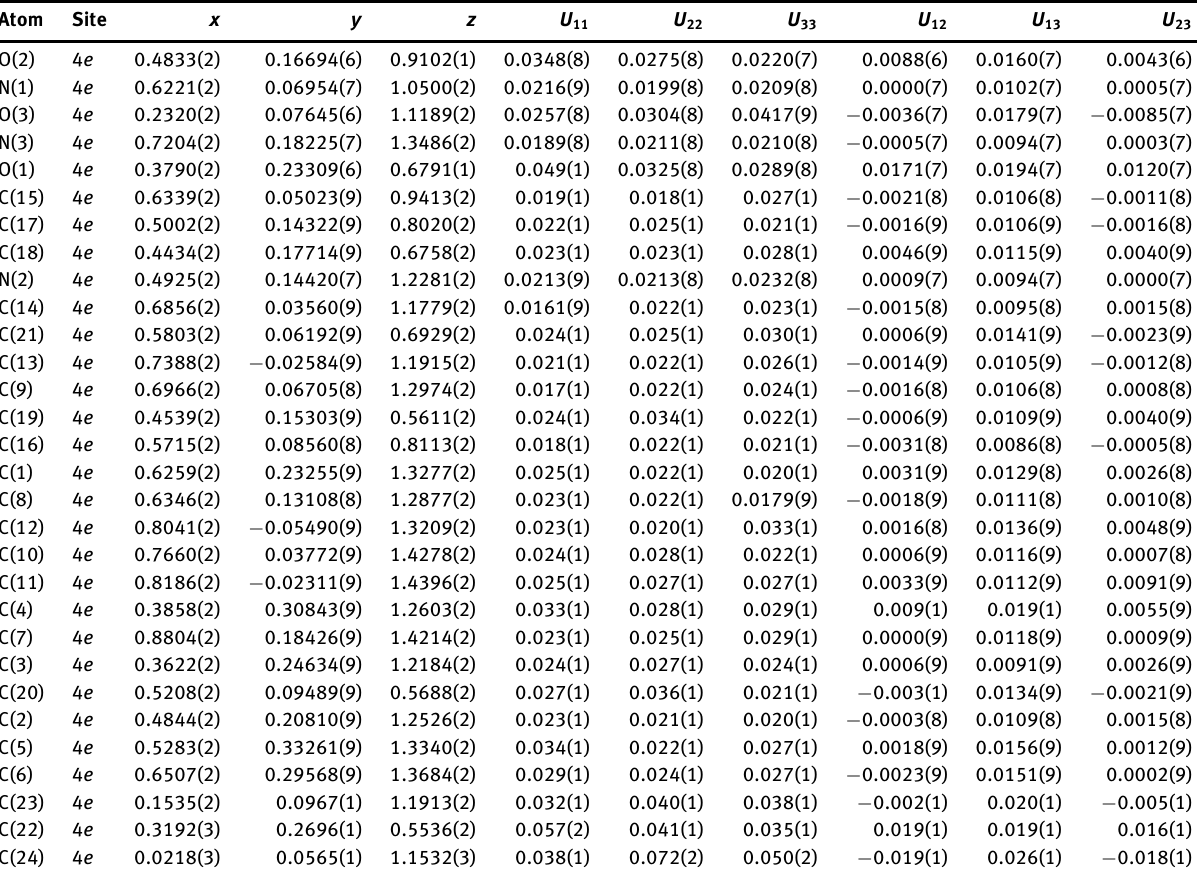
Table 3: Atomic displacement parameters (Å 2